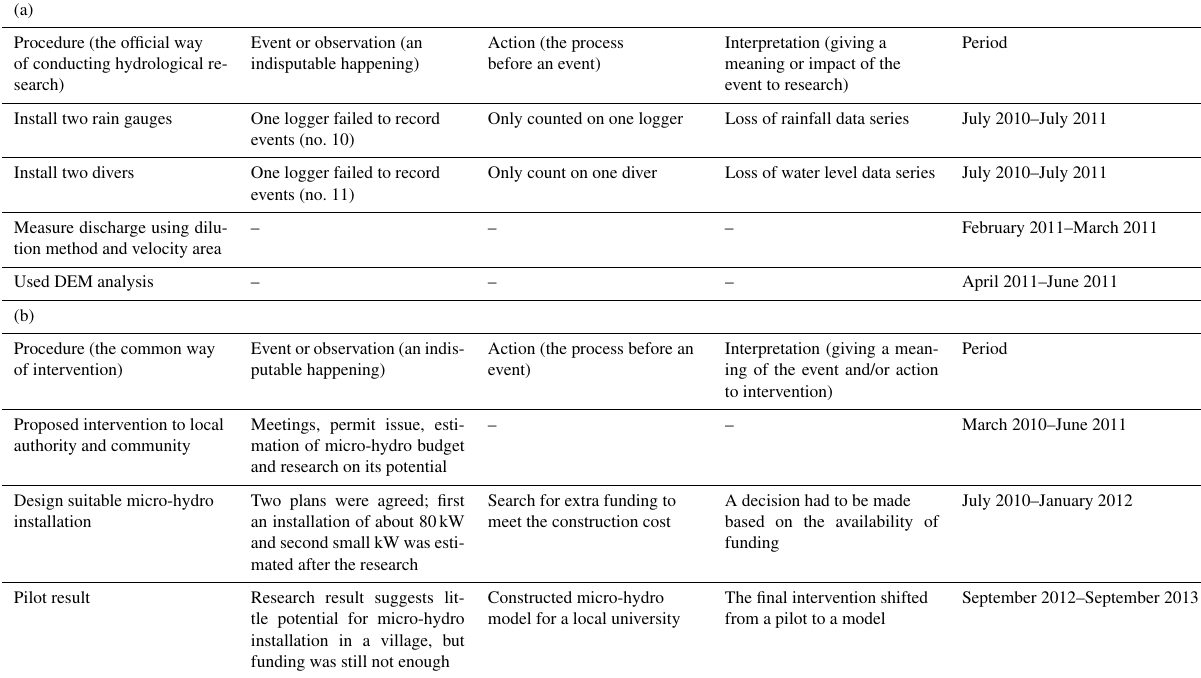
Table 3. (a) Indonesia case: hydrological research; (b) Indonesia case: intervention.